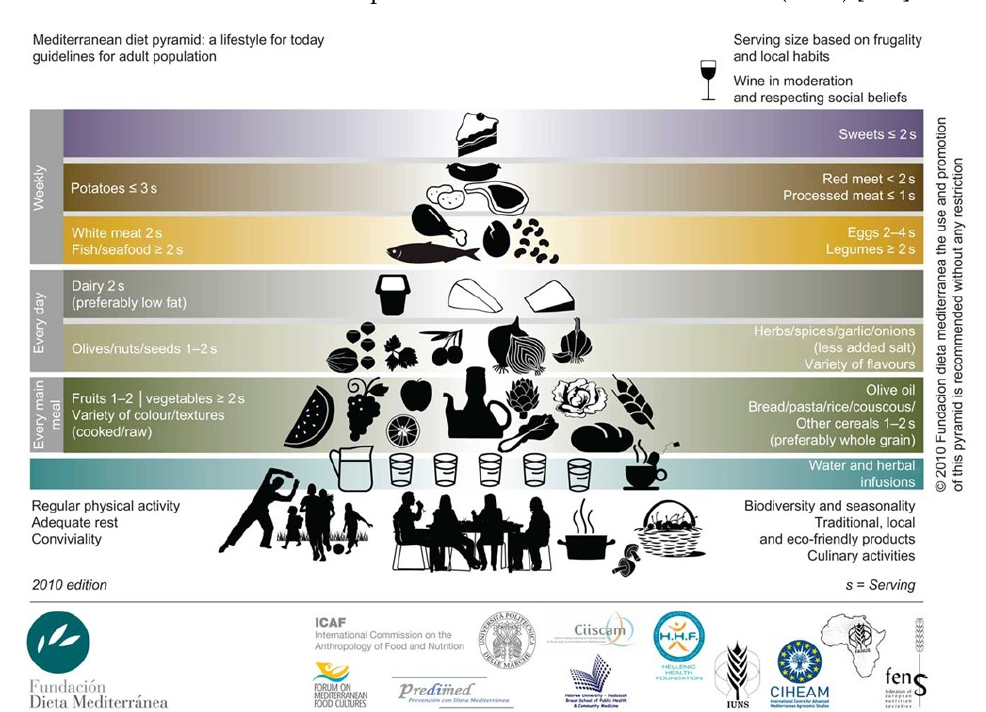
Figure 2. The concept of the healthy food pyramid is based on differences across countries which include food quality and quantity, social and cultural context, and economical aspects encountered in the Mediterranean basin. The graphical abstracts provide information about the type of seasonal food, weekly intake in relation to standard portions, and the role of macro- and micro-nutrients. The idea is that of promoting healthy lifestyles among different populations. The importance of regular physical activity and social relationships is also indicated. The final design of the MD pyramid today and a brief complementary text for the general public have been developed by the Mediterranean Diet Foundation Expert Group that includes the Mediterranean Diet Foundation’s International Sci- entific Committee expertise, the in situ discussions by a representative group of members that met within the Barcelona VIII International Congress on the Mediterranean diet, and several other ex- perts who provided support on the design, editing, and translation to 10 different languages (Eng- lish, French, Italian, Spanish, Catalan, Basque, Galician, Greek, Portuguese, and Arabic). With per- mission from Cambridge University Press, 2022 [ 200 ] . Website http://dietamediterra- nea.com/en/(accessed on 4 June 2022).